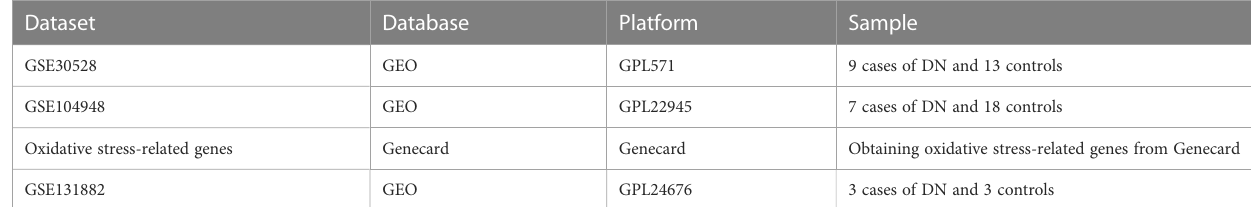
TABLE 1 Summary of the data sets utilized in this research and their